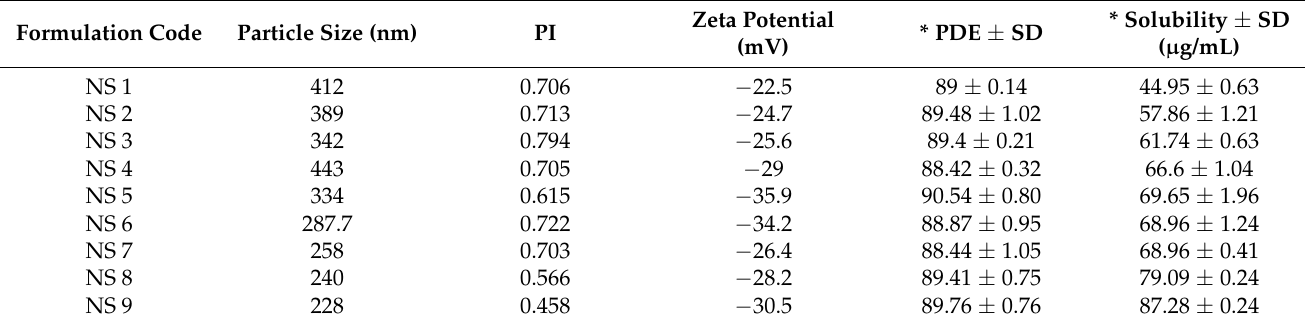
Table 7. Particle size, PI, zeta potential, PDE, and solubility of the NSs.